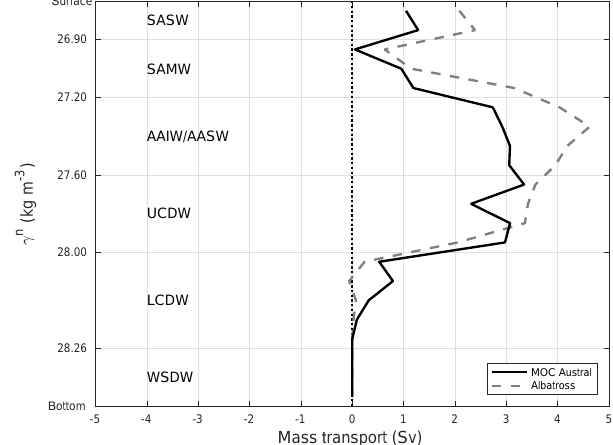
Figure 9. Relative geostrophic mass transport per layer across the ALBATROSS and MOC-Austral sections.